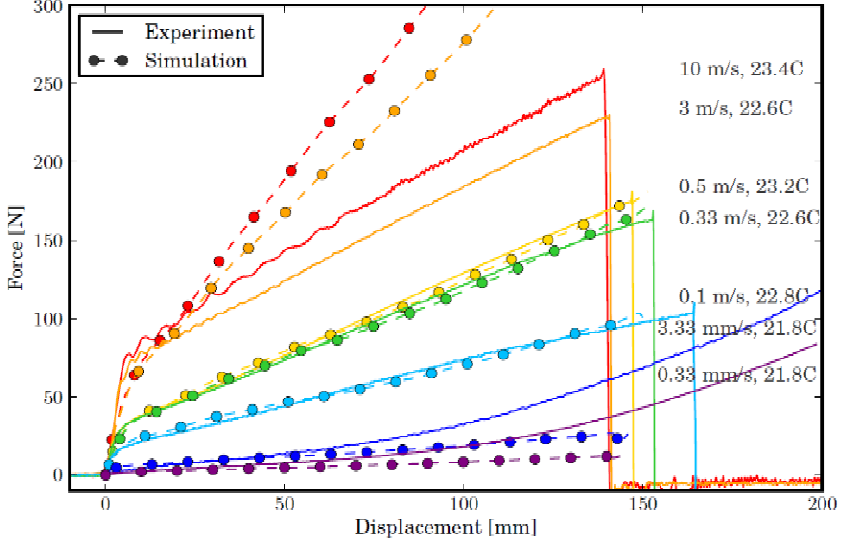
Fig. 13 Force vs. displacement for uniaxial tensile tests; simulated results for material model calibrated at 0.5 m/s and 23.2